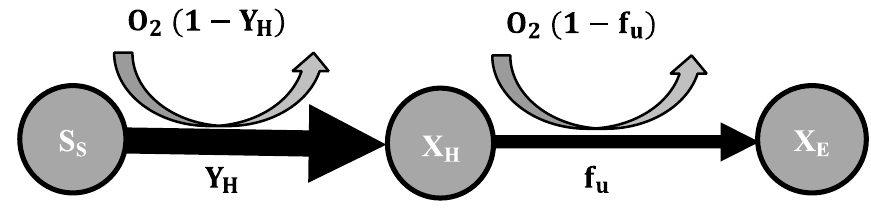
Figure 1. Principle of the endogenous respiration model.